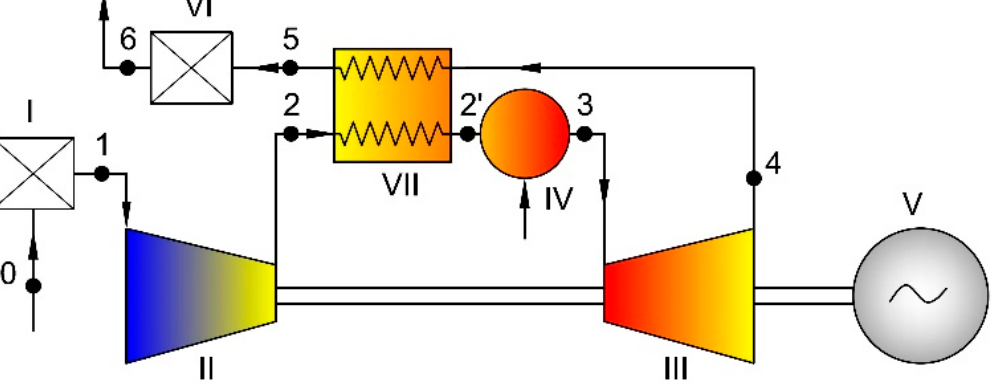
Figure 1. Turbine set operating according to the open cycle with regenerator (Variant 1-V1). I–filter; II–compressor; III–turbine; IV–combustion chamber; V–electric generator; VI–silencer; VII– regenerator.